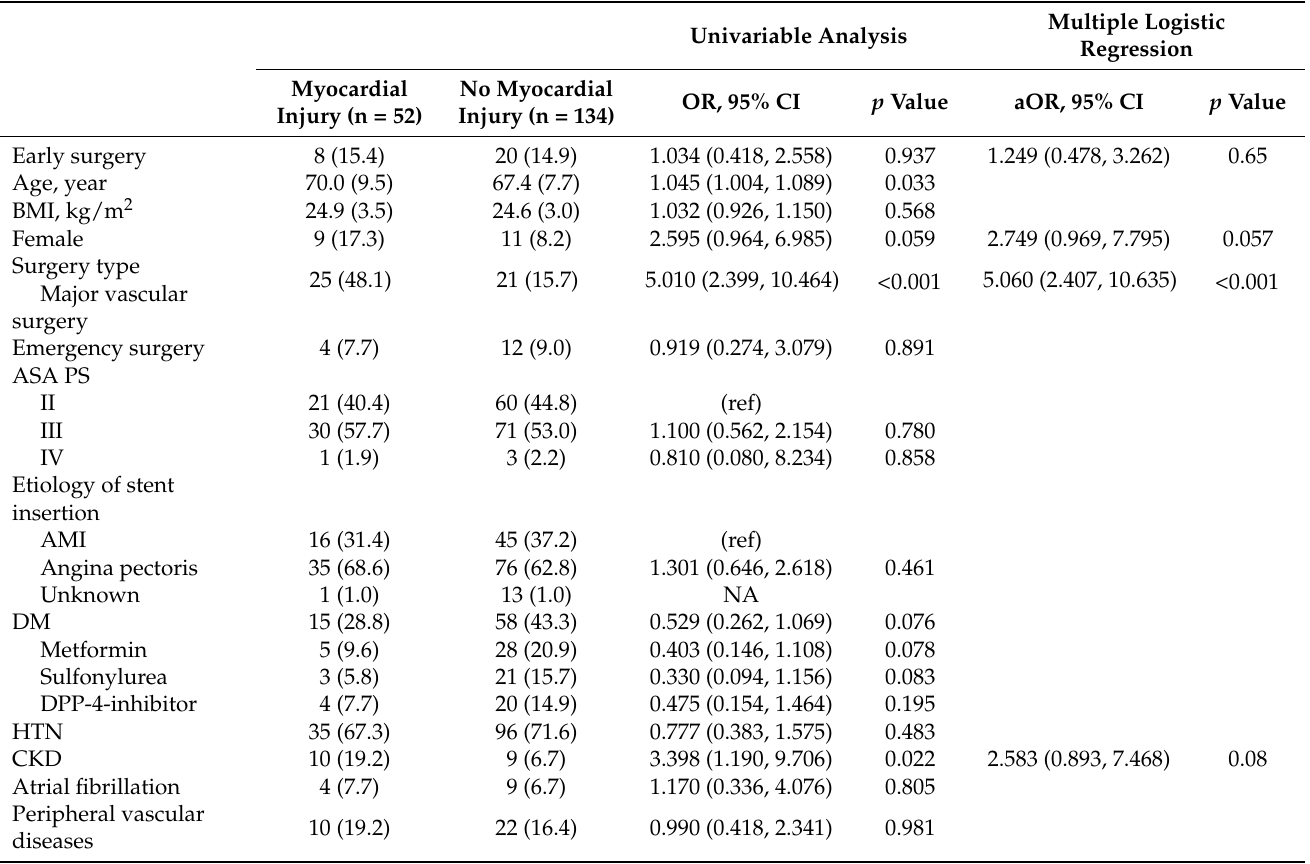
Table 3. Multiple logistic regression for myocardial injury (raw data).